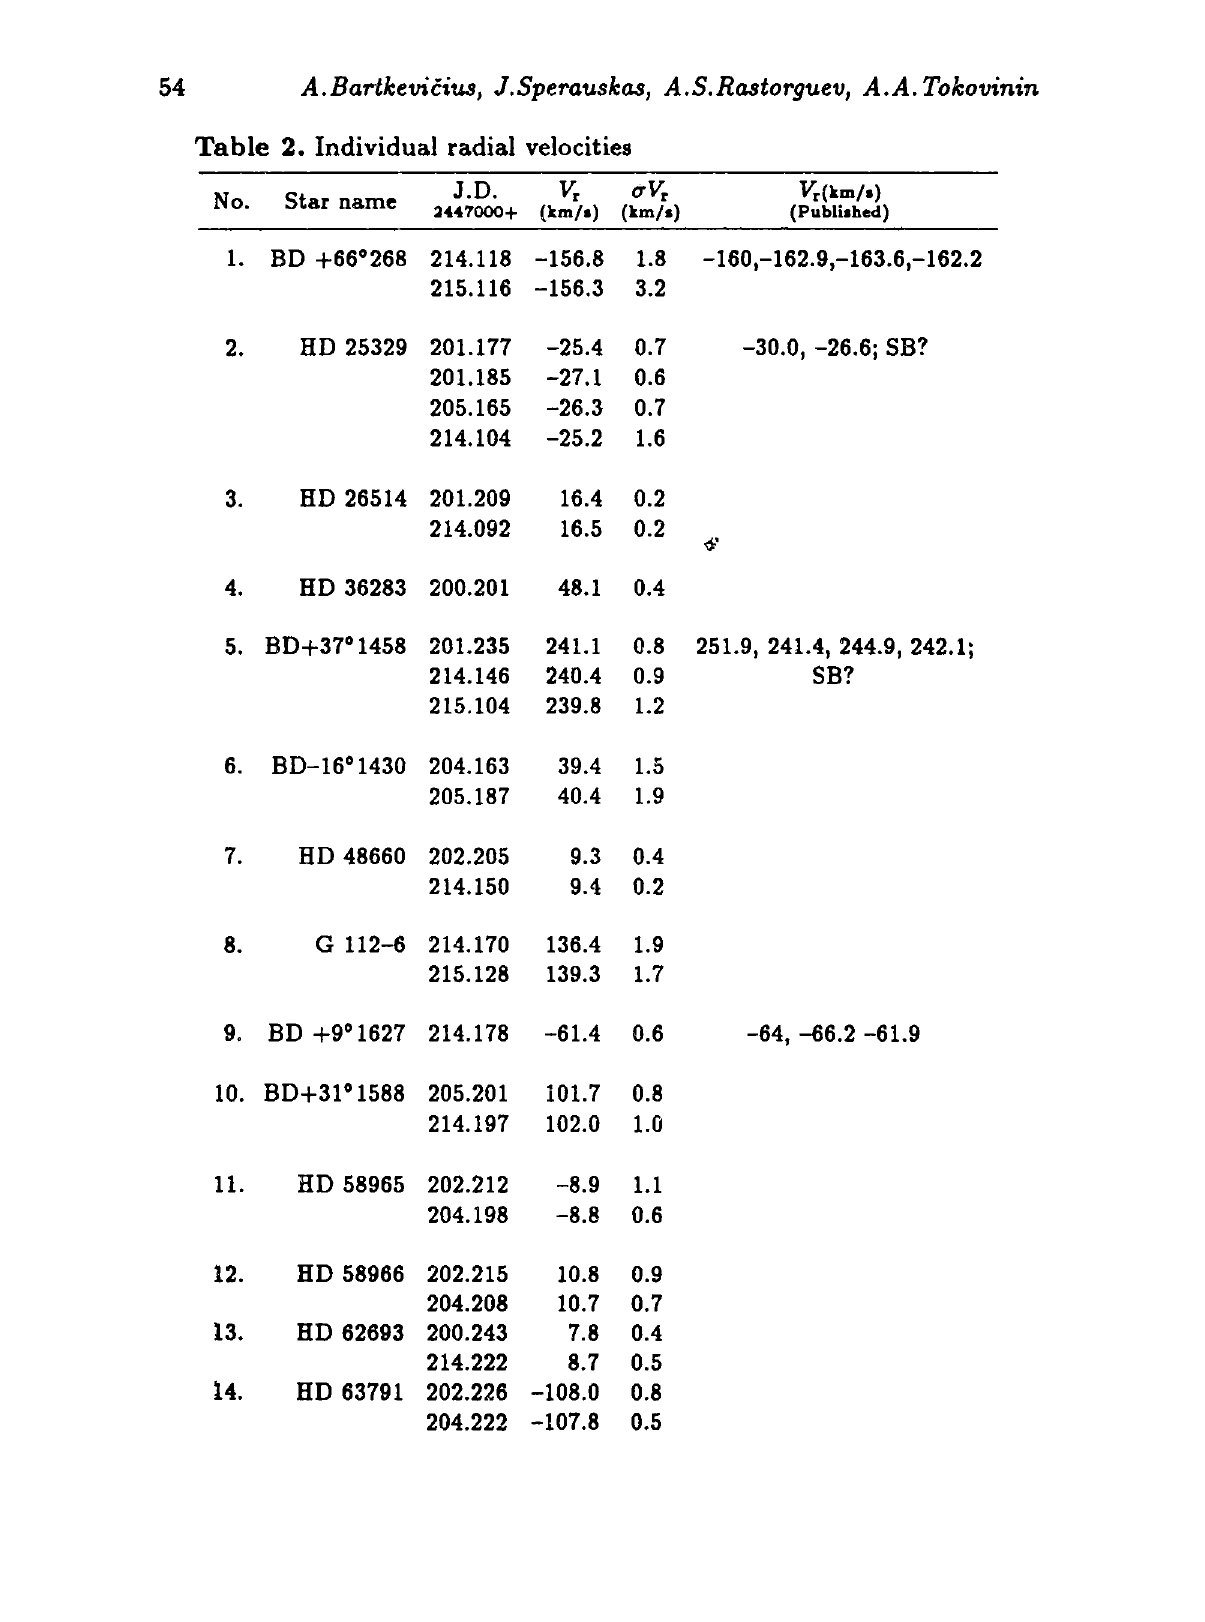
Table 2. Individual radial